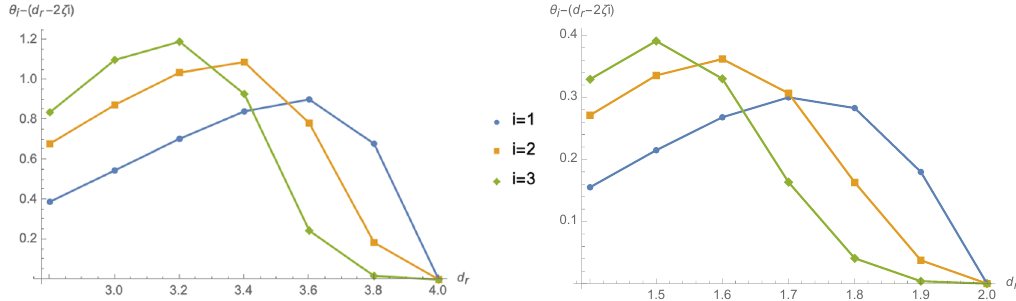
Figure 3 . Difference δθ i ( r, ζ ) = θ i − ( d r − 2 ζi ) of the first three scaling exponents i = 1 , 2 , 3 for ζ = 1 (left) and ζ = 1 / 2 (right) as a function of d r = r − 1 (without anomalous dimension, large- N k limit). All exponent values are converged up to two significant digits at